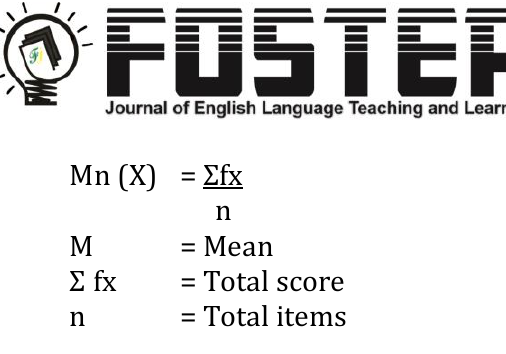
Table 2. Data Conversion Table was adapted from (Suharto 2006) in Alex Sander (201 8)